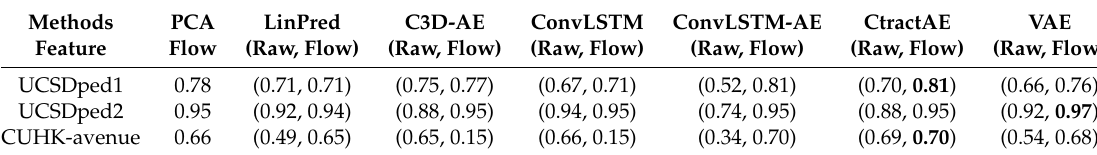
Table 2. Area Under-Precision Recall